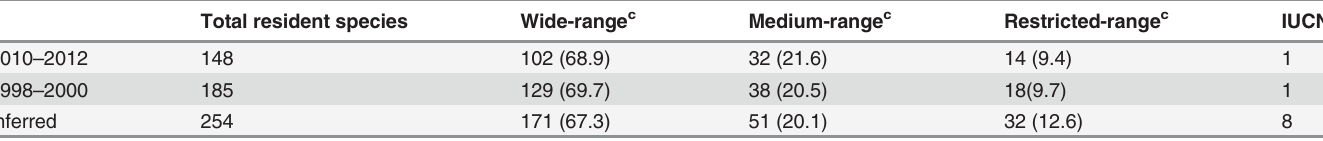
Table 1. Numbers of resident bird species in Mengsong, including species occurring there in 2011 – 2012, in 1998 – 2000 (Wang and Young 2003) a , and inferred b